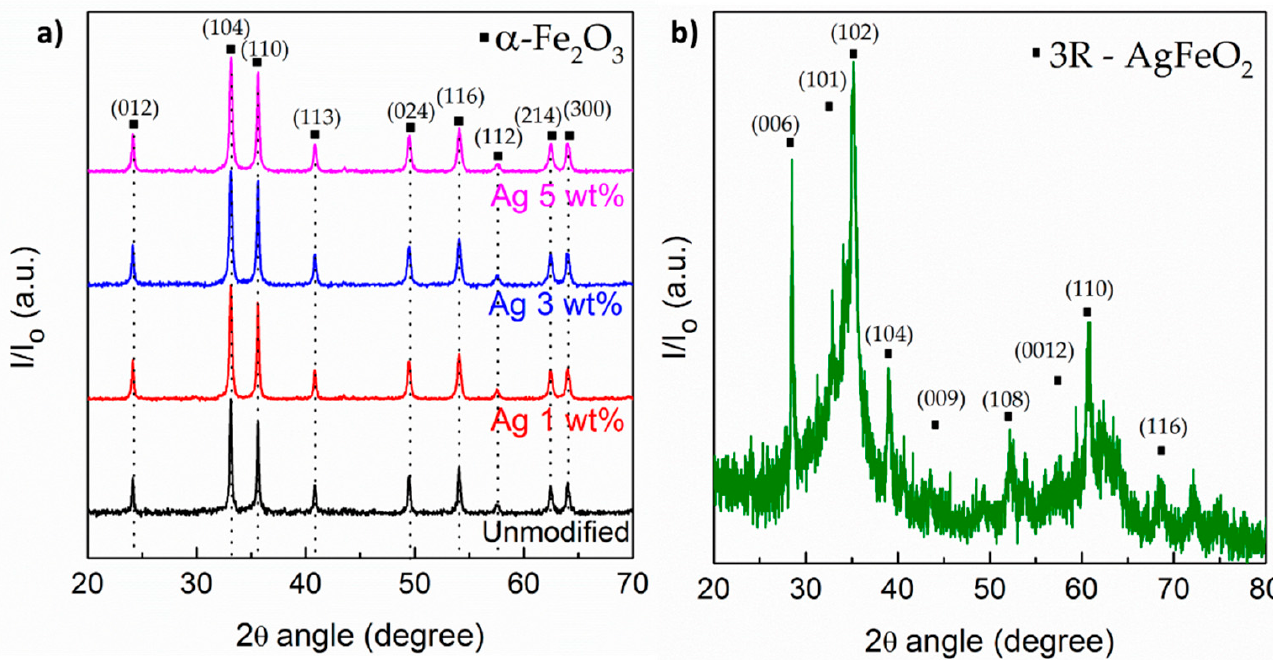
Figure 4. X-ray diffractogram of ( a ) pristine hematite and α -Fe 2 O 3 /Ag nanocomposites with 1 to 5.0 wt% of Ag, and ( b ) typical diffractogram of delafossite 3R-AgFeO 2 of the composite material prepared with 10.0 wt% of silver.